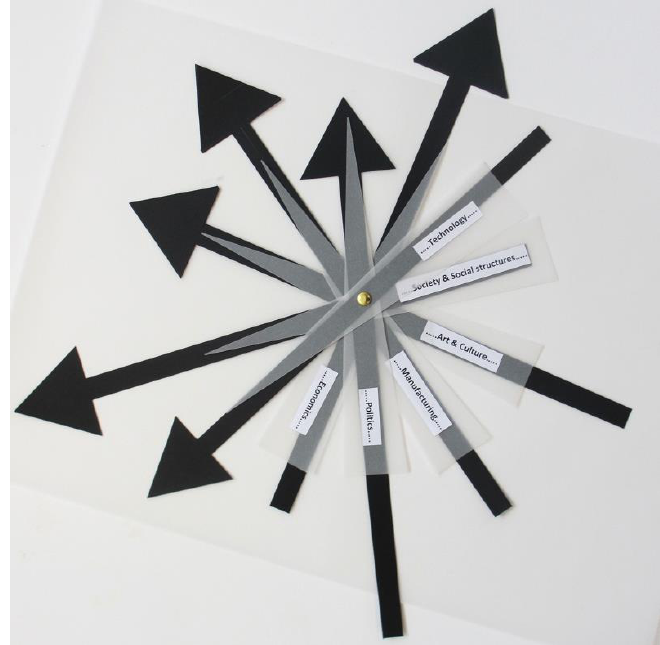
Figure 3. The Assemblage Infrastructure. Rachel Matthews 2018. Example of a teaching resource used to initiate the production of a fashion’s history assemblage as a group learning activity.